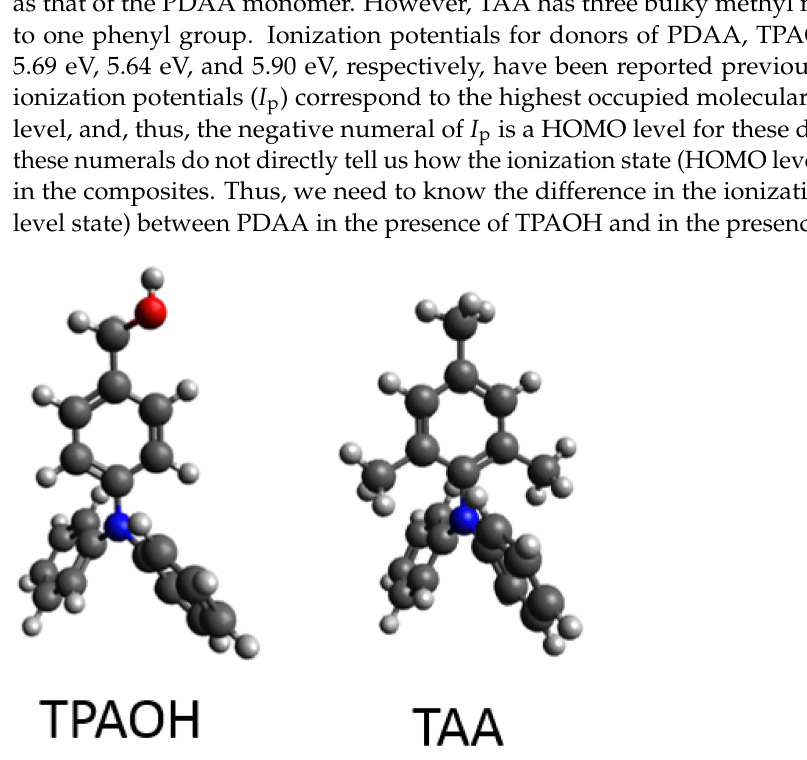
Figure 1. Molecular structures of TPAOH and TAA energetically stabilized using a molecular orbital simulation. Theoretical calculations with the Guassian09 package software, using the functional/basis set RB3LYP, were